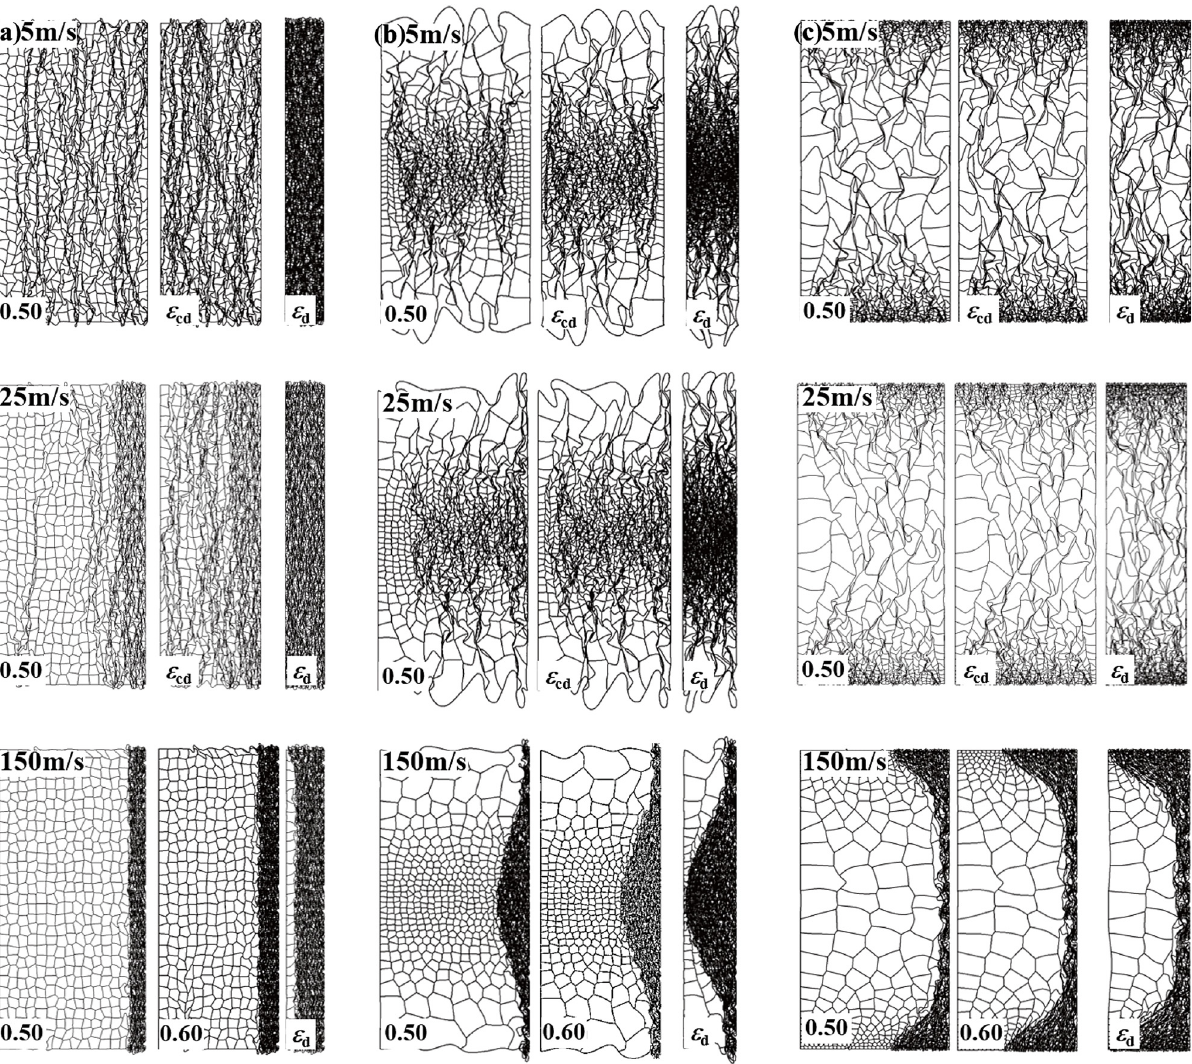
Figure 7: Deformation modes of Voronoi structures. Impact velocities are 5, 25, and 150 m · s − 1 , respectively. Gradient coe ffi cient a = ( a ) 0, ( b ) 0.35, and ( c ) −